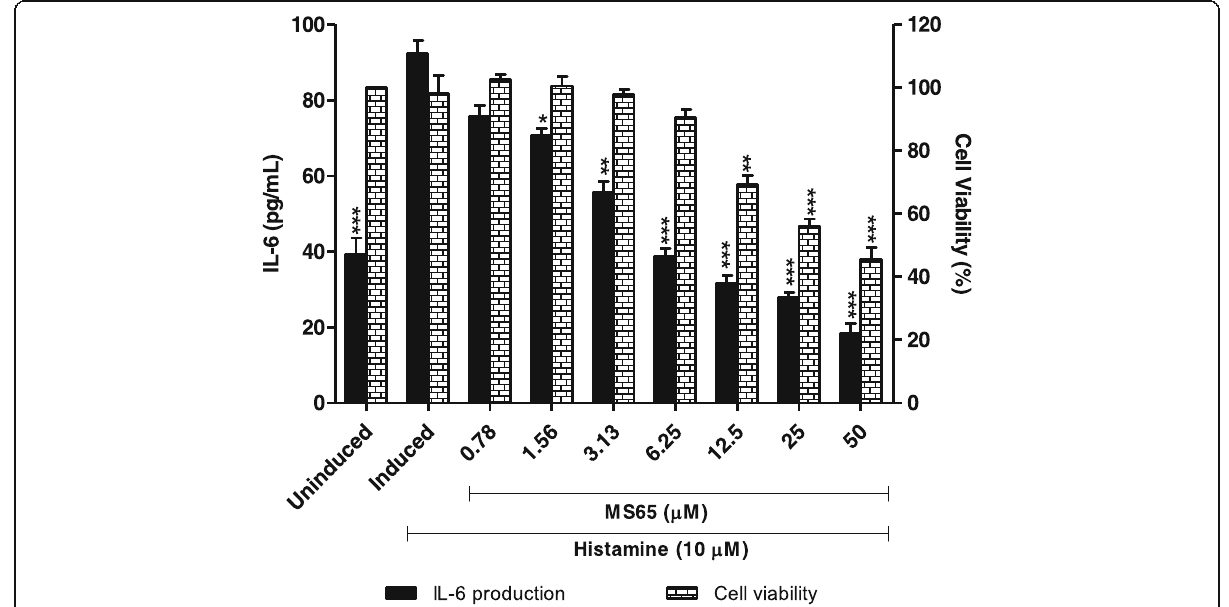
Fig. 2 Effects of curcumin derivative, MS65 on IL-6 production and cells viability in histamine-induced HaCaT cells. Cells were seeded for 24 h before inducing with 10 μ M of histamine. MS65 was tested in two-fold serial dilution with the highest concentration of 50 μ M. Cells were then further incubated for 24 h. All values are the mean ± S.E.M. of three independent experiments. Values of * P < 0.05, ** P < 0.01 and *** P < 0.001 were considered significantly different to histamine-induced control